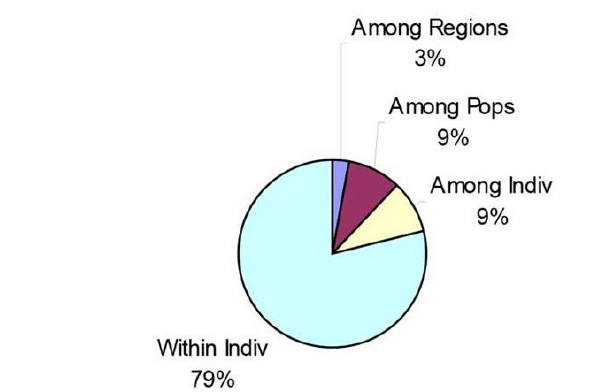
Figure 2. Analysis of Molecular Variance (AMOVA) based on ten microsatellite markers used to genotype 96 individuals taxonomi- cally assigned to R. corsica (six populations) and 60 individuals tax- onomically assigned to R. lamarmorae (one population divided in two sub-populations). The two regions considered in this analysis represent the two